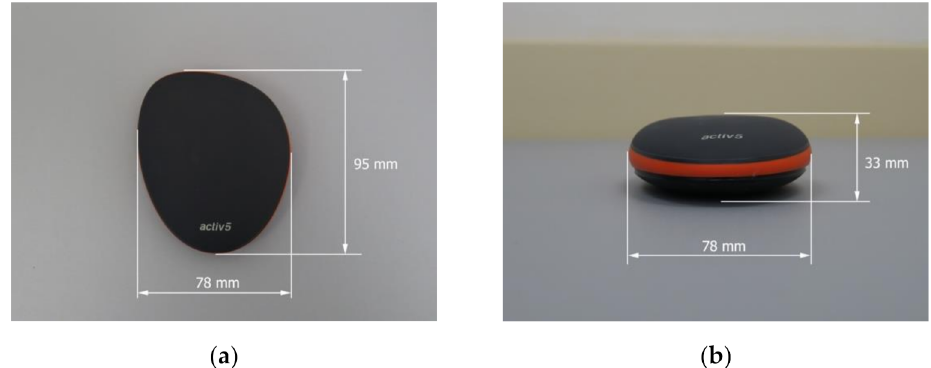
Figure 1. Technical characteristics of portable isometric-based strength training device Active5™: ( a ) Length and width; ( b ) width and height. The weight exceeds 131 g, including the battery.